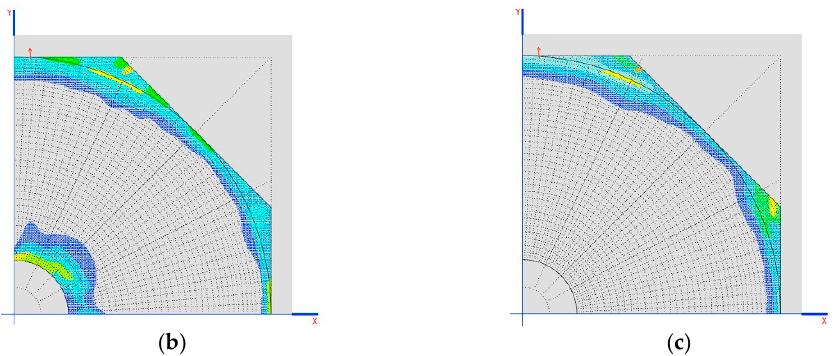
Figure 12. ( a ) Scheme of displacement of the point of anchorage of the connecting rod with the arches; ( b ) traction in the dome (MPa) in the penultimate phase of construction; ( c ) traction in the dome (MPa) in the last phase of construction.